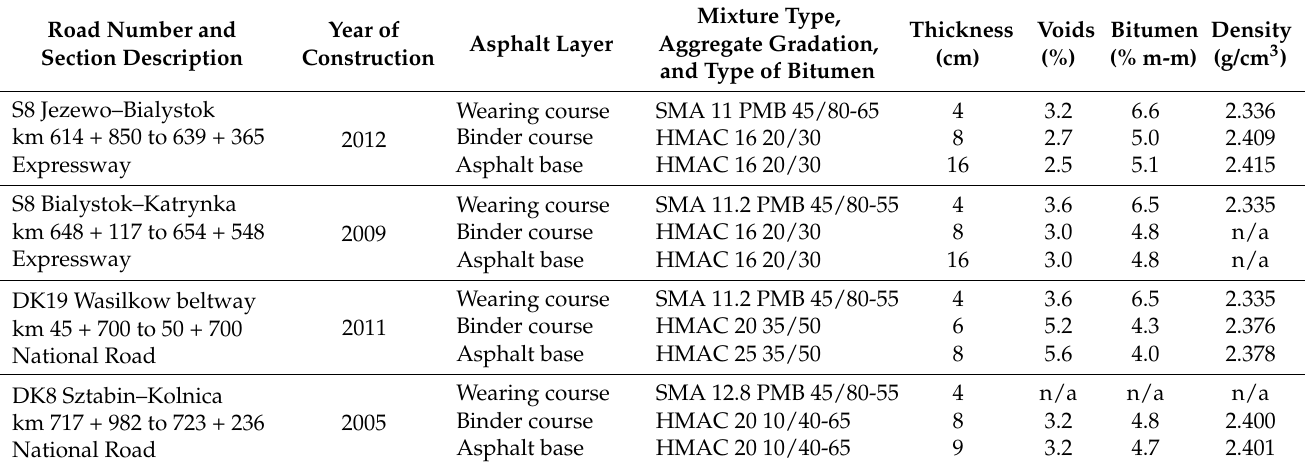
Table 1. Asphalt courses of the analyzed